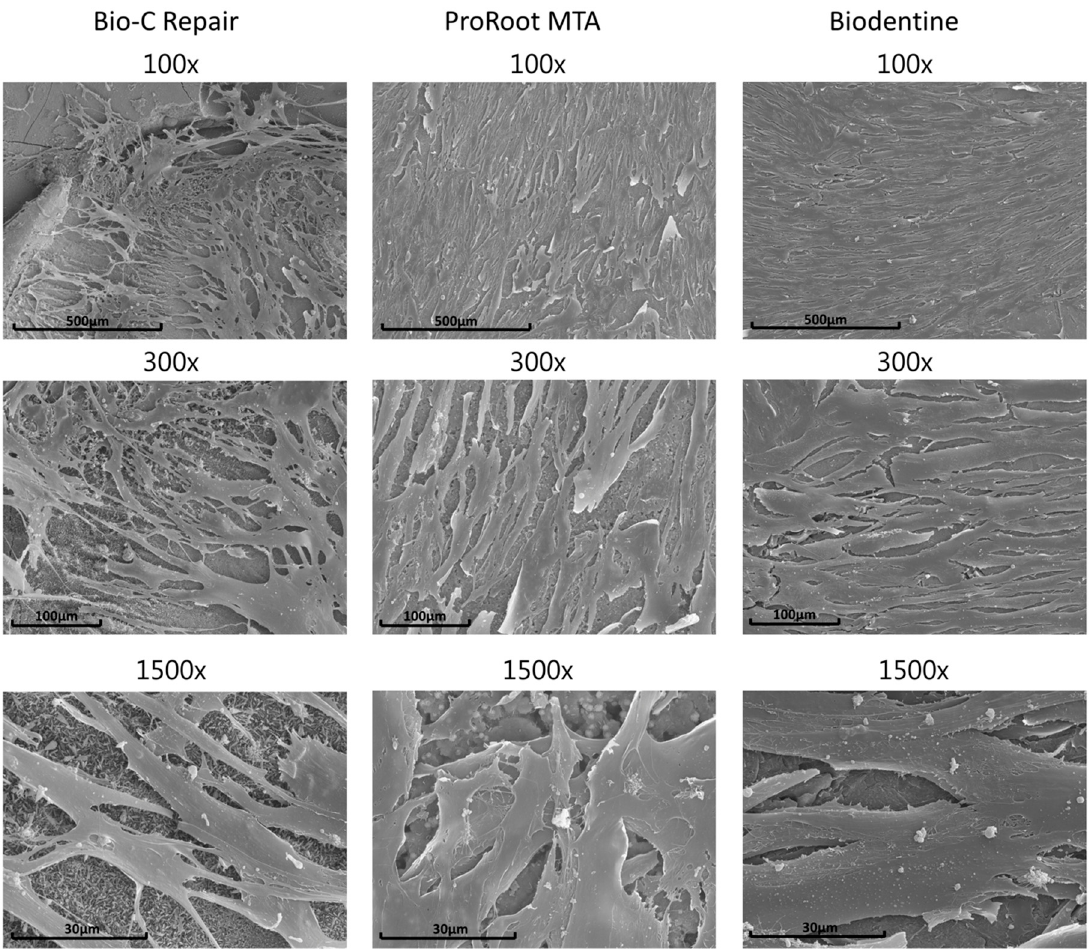
Figure 3. SEM images of human dental pulp cells (hDPCs) cultivated on vital pulp material (Bio-C Repair, ProRoot MTA, and Biodentine) surfaces after 72 h of culture. Magnifications of 100 × , 300 × , and 1500 × . Scale bars: 500 µ m, 100 µ m, and 30 µ m.